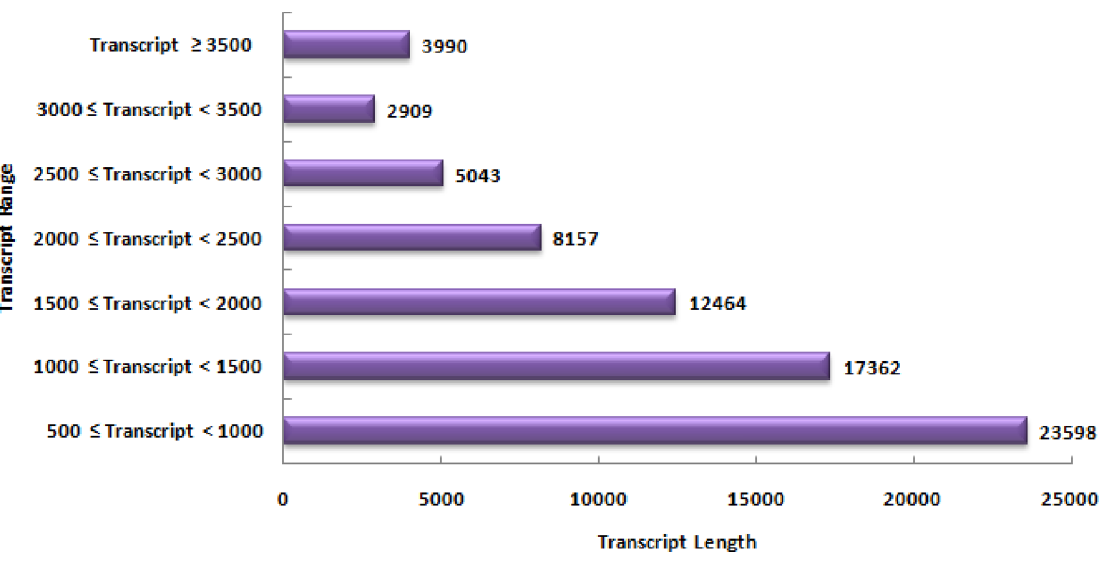
Figure 2. Distribution of transcript contig length in RNA-Seq data of W.somnifera .